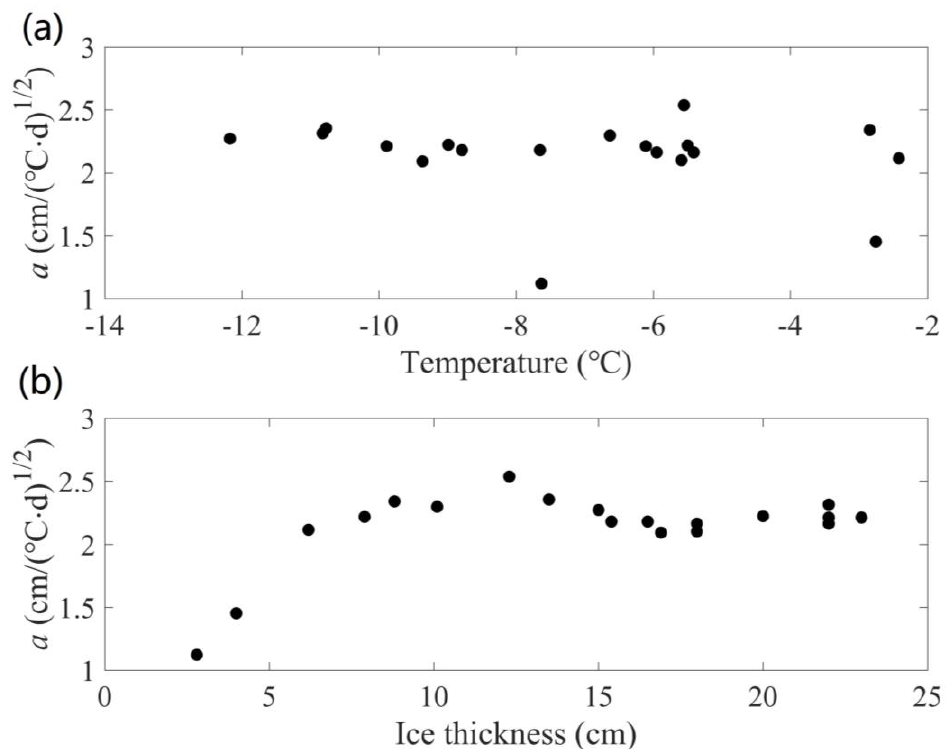
Figure 7. ( a ) The relationship between temperature and freezing rate; ( b ) relationship between ice thickness and freezing rate.